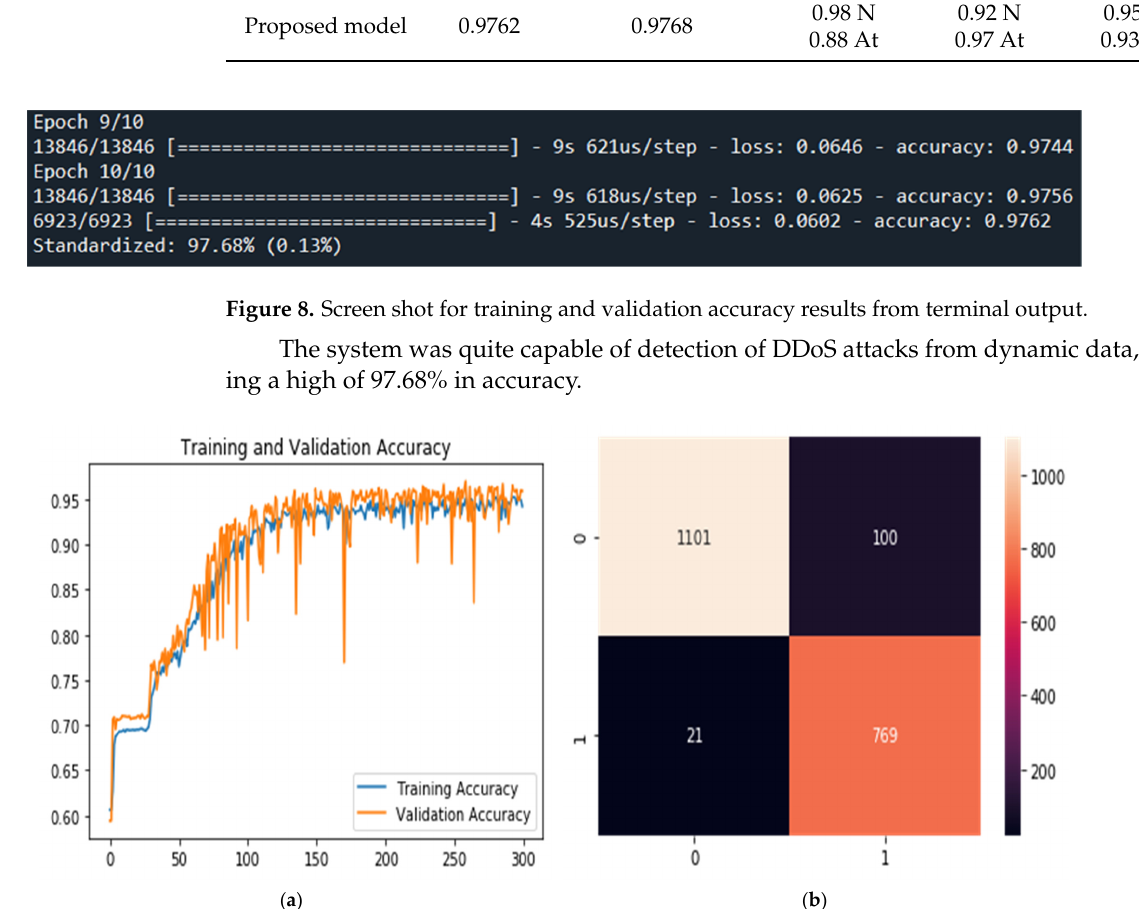
Figure 7. ( a ) Feature density matrix. ( b ) DeepInsight for train data. Table 9. BDLSTM-autoencoder model results for DDoS detection of an emulated test of the BDLSTM-autoencoder model.